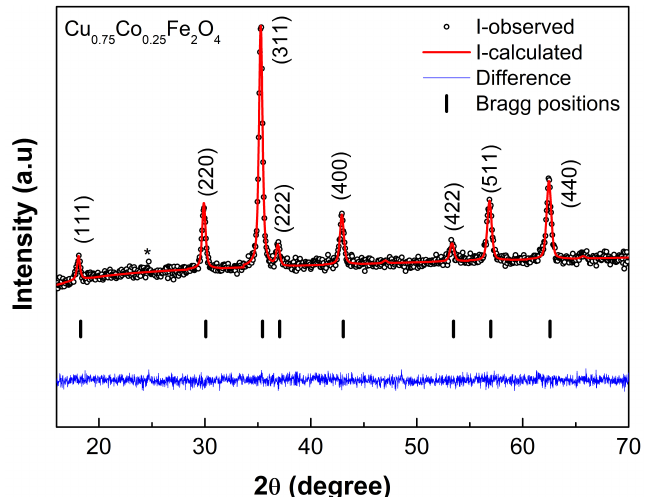
Figure 1. XRD pattern as well as Rietveld refinement of the Cu 0.75 Co 0.25 Fe 2 O 4 ferrite nanoparticles. The experimental data are represented by black circles, the calculated data by a red line, and the difference between the two by a blue line. Bragg positions are represented by black vertical bars. The star at 2 θ = 25 ◦ might be the result of a trace amount of unknown